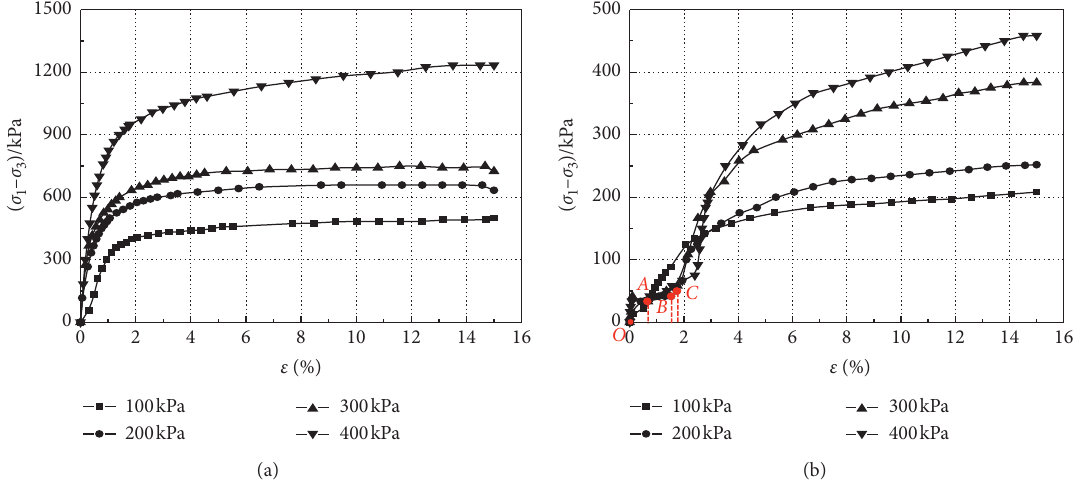
Figure 5: Stress-strain behaviour under four confining pressures: (a) coral mud and (b) Taizhou